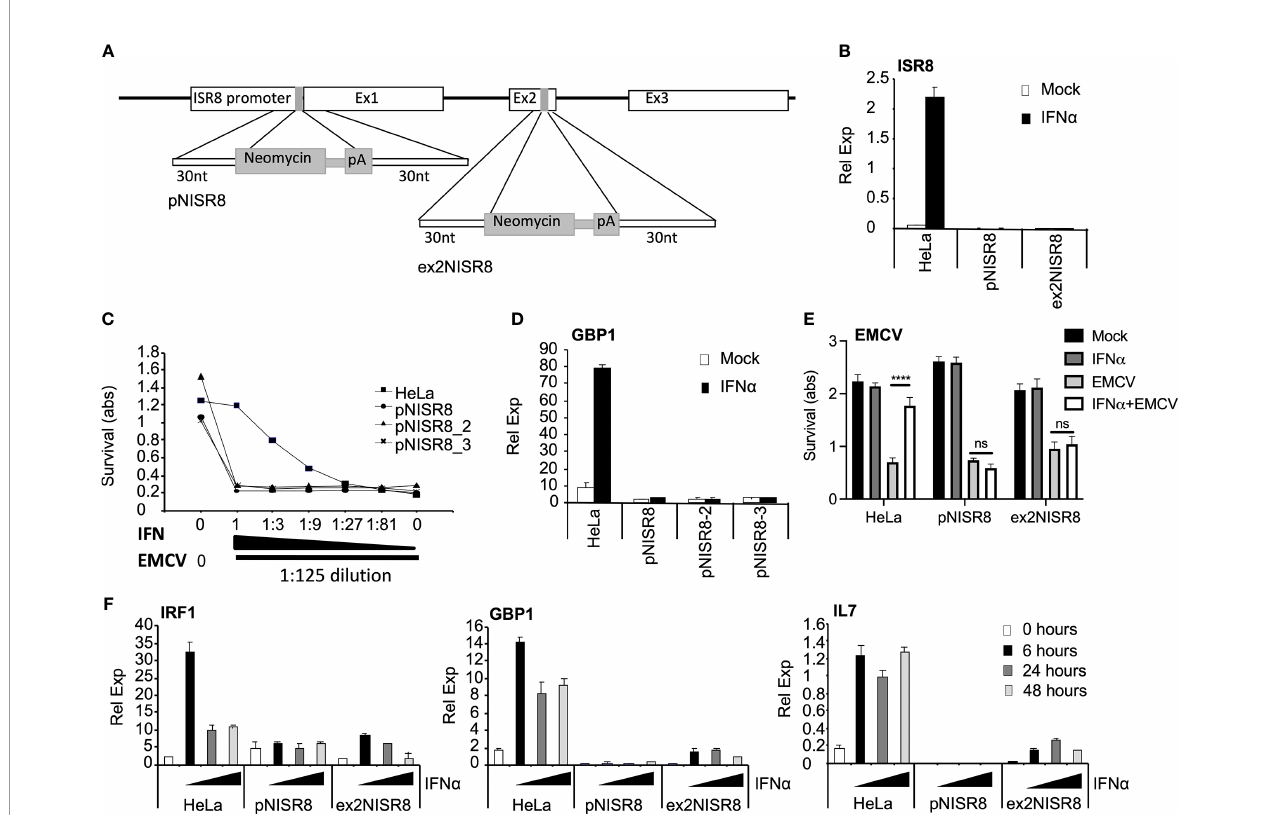
FIGURE 2 | Analysis of ISR8 -disrupted clones obtained by CRISPR-Cas9 genome editing technique. (A) Schematic of the neomycin cassette and the insertion in ISR8 promoter and exon 2 to obtain the pNISR8 and ex2NISR8 stable cell lines. (B) ISR8 mRNA levels in the indicated cells treated with 0 or 1000 U/ml IFN a for 6 h. (C) Survival of the indicated cells after treatment for 6h with decreasing doses of IFN a (0, 0.045, 0.123, 0.41, 1.23, 3.7 and 11.11 U/ml IFN a ) and EMCV infection for 18h. (D) GBP1 mRNA levels in the indicated cells treated with 0 or 1000 U/ml IFN a for 6 h. (E) Similar to C but with 11.11 U/ml IFN a . (F) GBP1, IRF1 and IL7 mRNA levels were measured in the indicated cells treated with 0 or 1000 U/ml IFN a for the indicated times. GAPDH mRNA was also measured in all RT- qPCR evaluations and used as a reference. Error bars indicate standard deviations. Experiments were performed at least four times except C and E, which were performed twice and a representative fi gure is